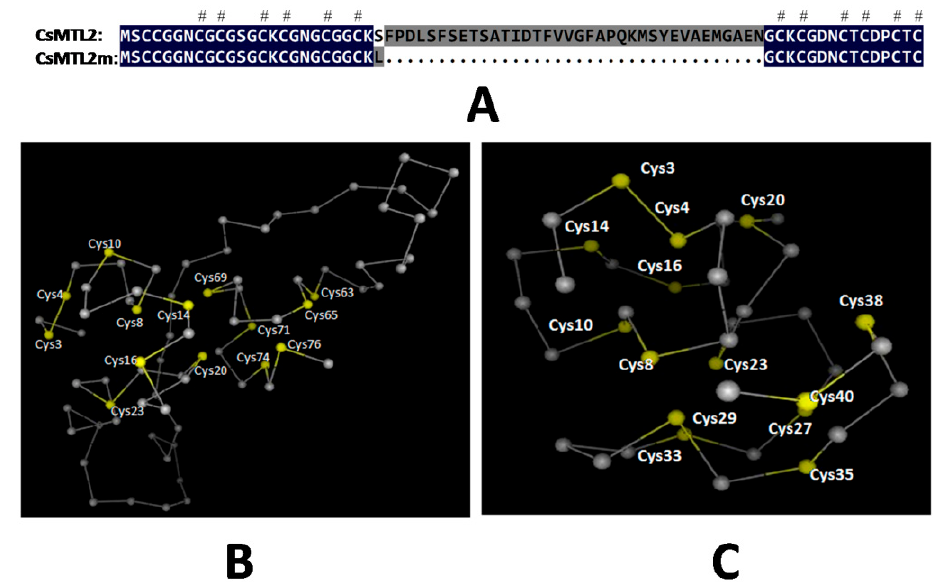
Figure 3. Schematic protein structure of CsMTL2 and CsMTL2m. ( A ) Comparison of deduced amino acid sequences of CsMTL2 and CsMTL2m. The blue background indicates shared amino acid residues. The gray background and dots denote differences between CsMTL2 and CsMTL2m. The hash symbol represents conserved Cys motifs. ( B ) Predicted 3D structure of-full length CsMTL2. Yellow and gray dots indicate the Cys motifs and other deduced amino acids co-linked by peptides (gray lines). ( C ) Predicted 3D structure of CsMTL2m, which lacks the linker region.